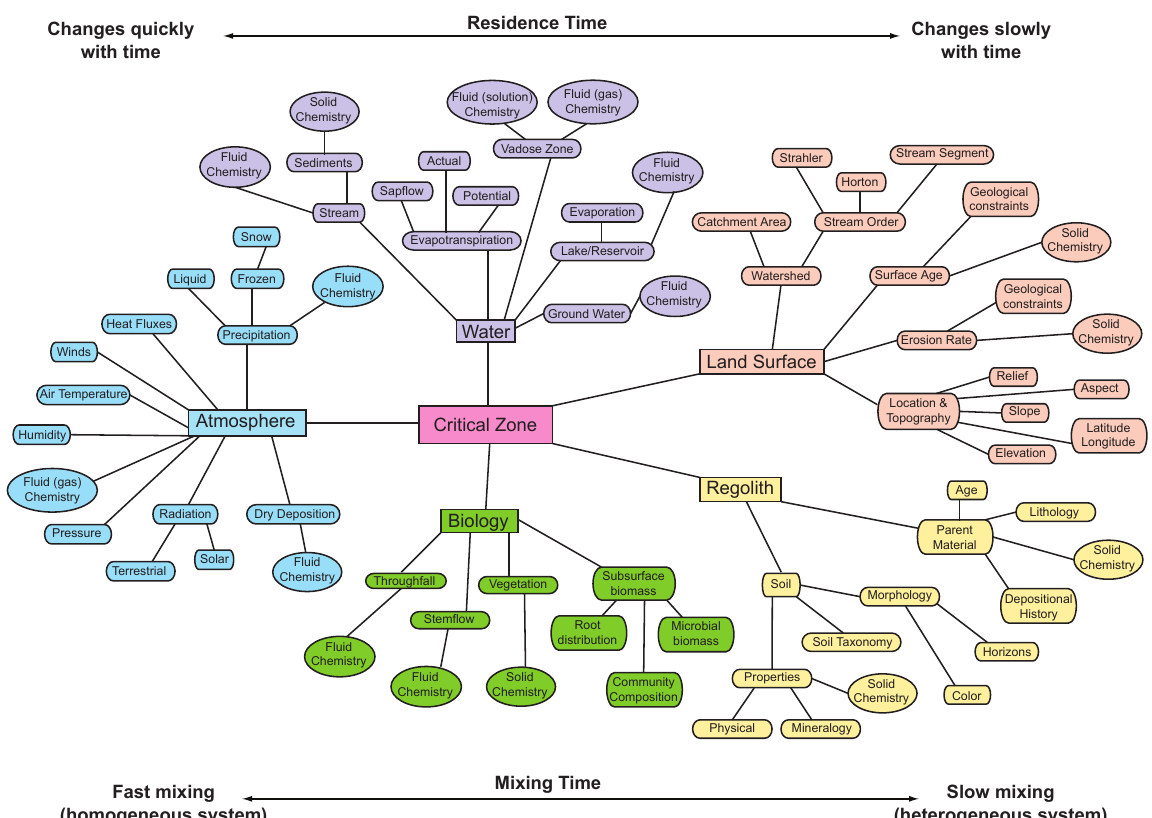
Figure 4. A schematic diagram showing some of the major entities that can be measured as part of the critical zone. The colors code entries related to the atmosphere (aqua), water (indigo), land surface features (beige), regolith (yellow), and biota (green). As shown by arrows, the entities are organized on the diagram from short to long residence times (left to right, respectively), and these correlate with generally fast to slow mixing times, respectively. Reproduced with permission from Niu et al.